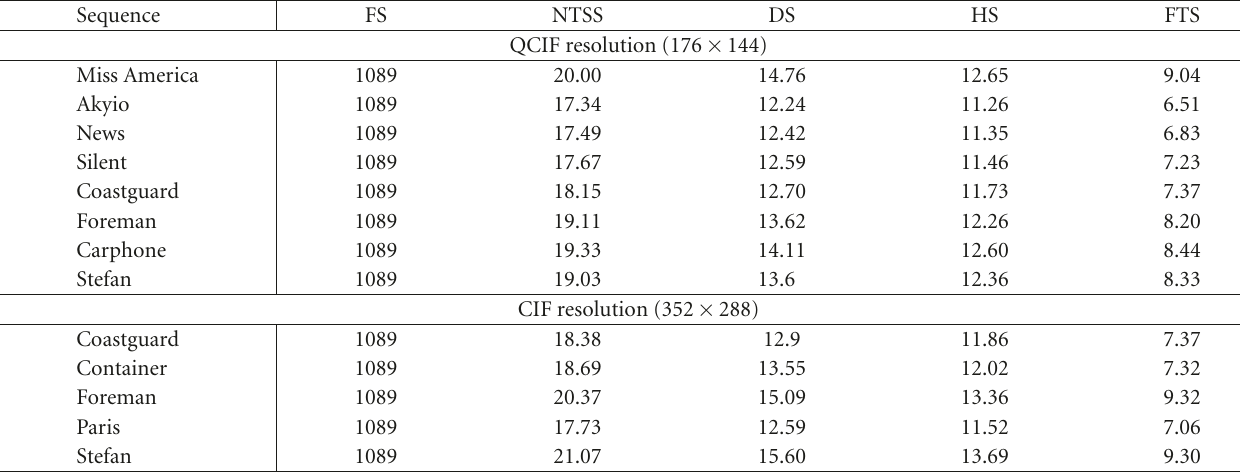
Table 3: Average number of block matching per macroblock.